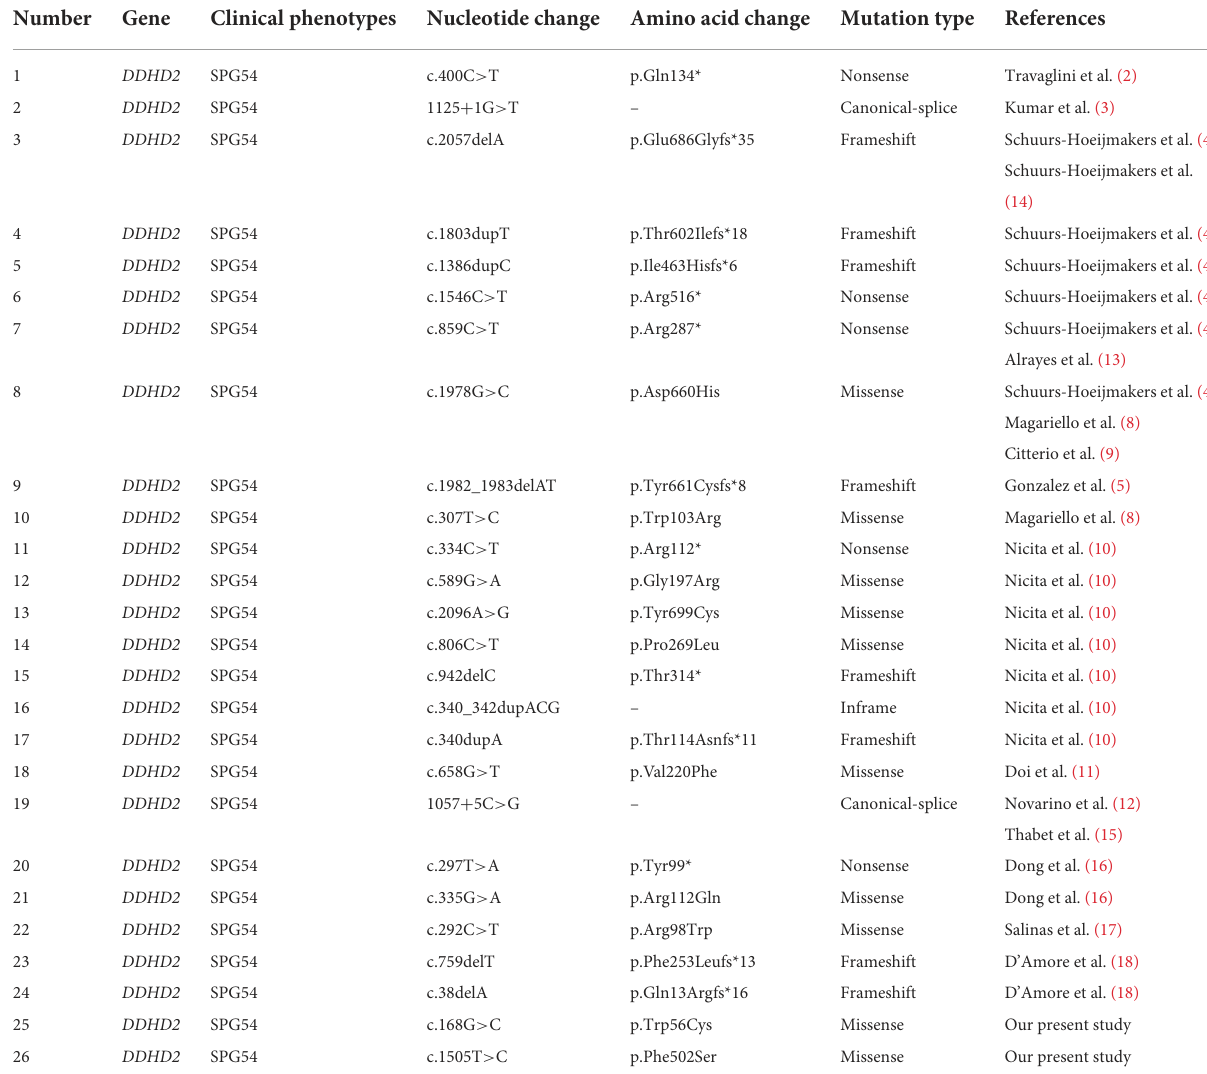
TABLE 2 DDHD2 mutations associated with